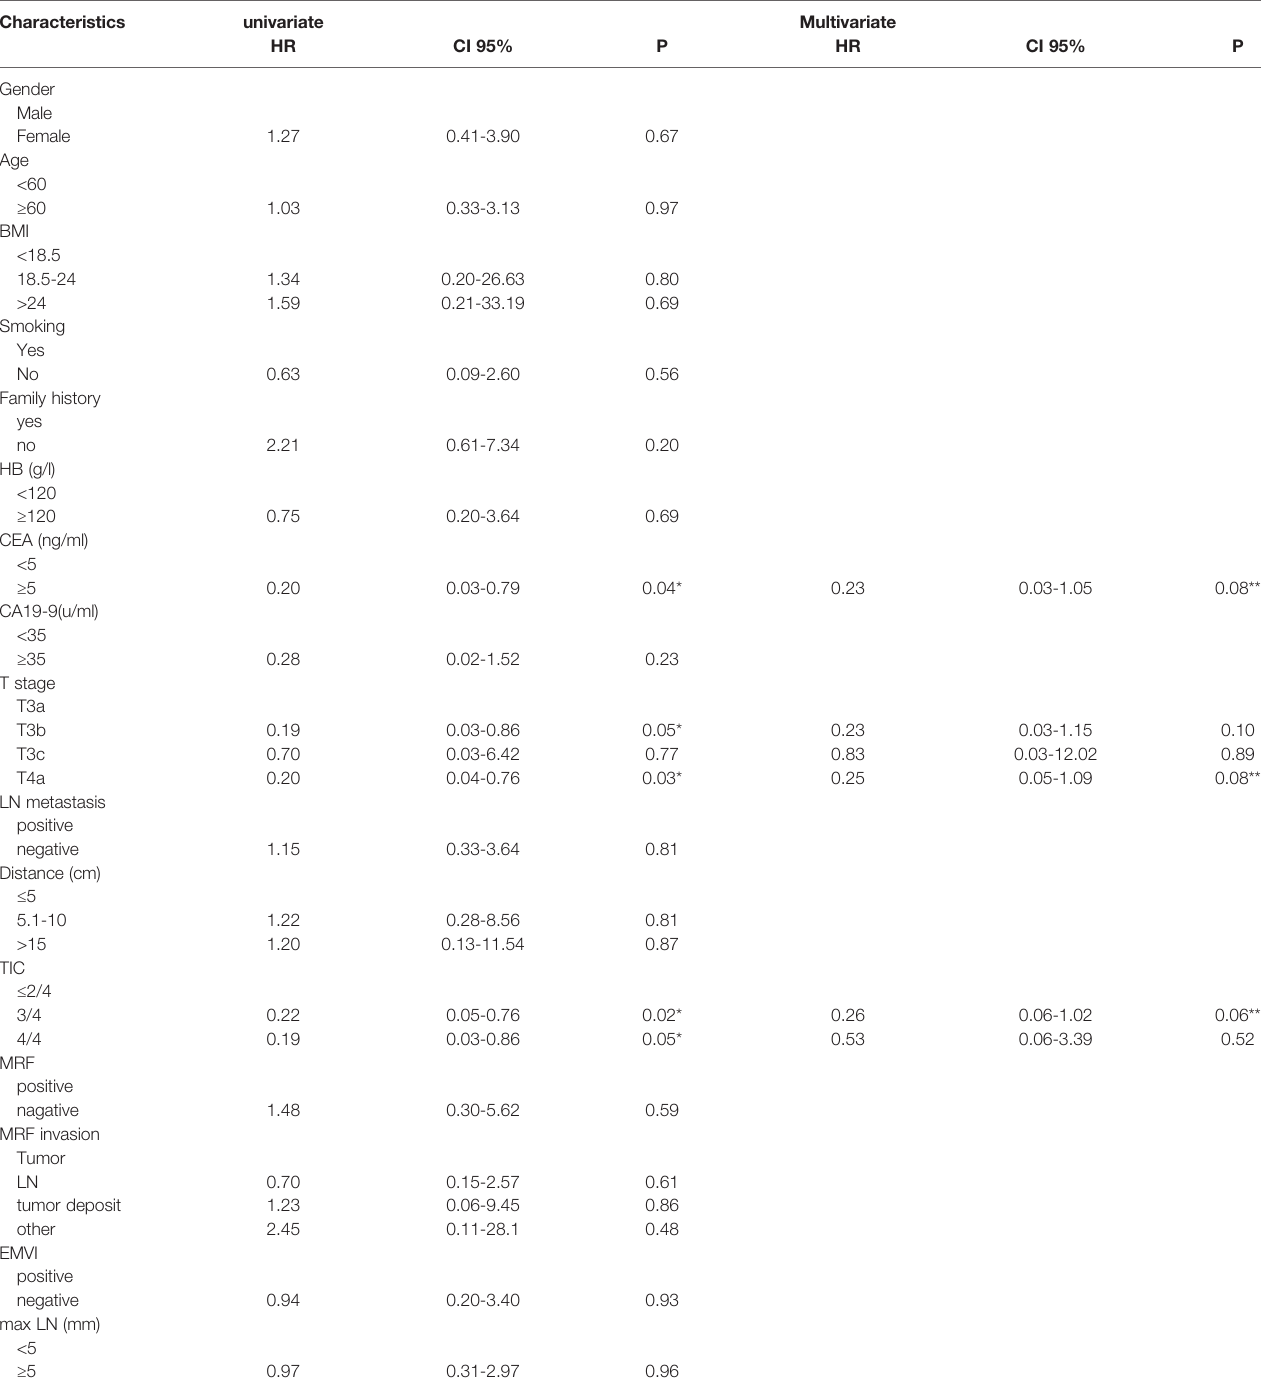
TABLE 3 | Univariate and multivariate analyses of the clinical characteristics.